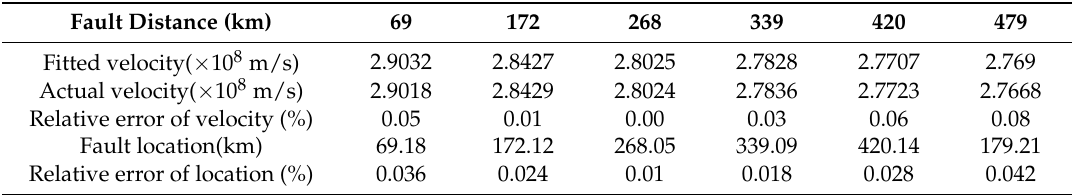
Table 4. The influence of fitting error on the fault location